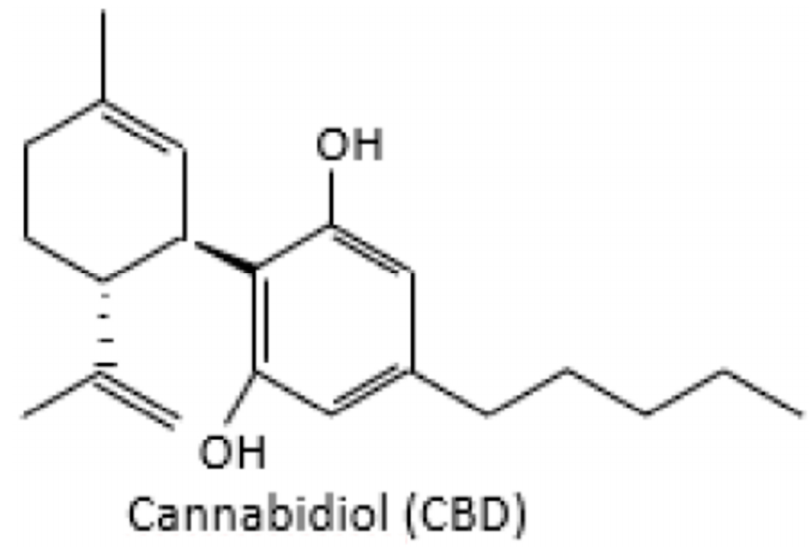
Figure 1. The structure of CBD.